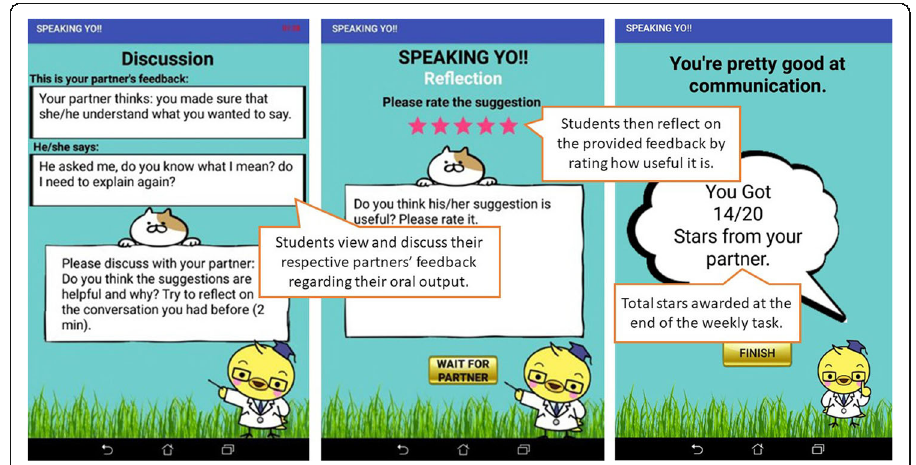
Fig. 4 Discussion/reflection on peer feedback (Phase